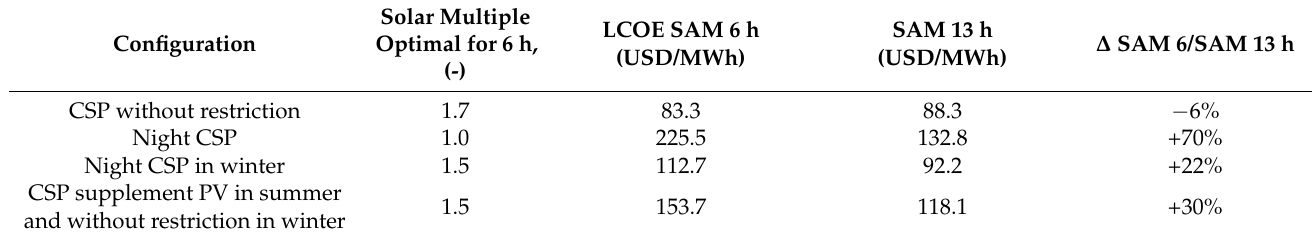
Table 11. Economic results for the CSP plant with 6 h of storage.